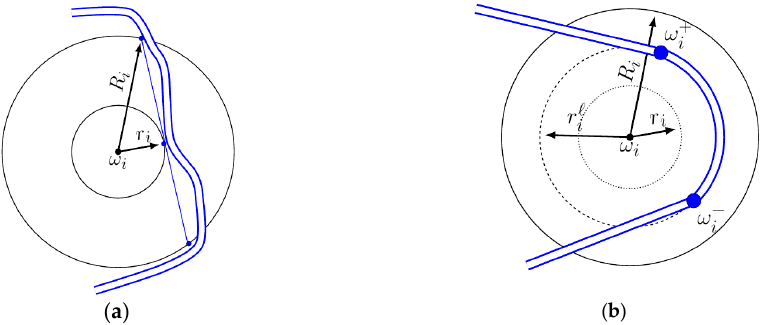
Figure 2. Illustration of different aspects of the trajectory design: ( a ) inner and outer communication constraints with a sufficient condition and a corridor for the UAV trajectory envelope and ( b ) trajectory validating.